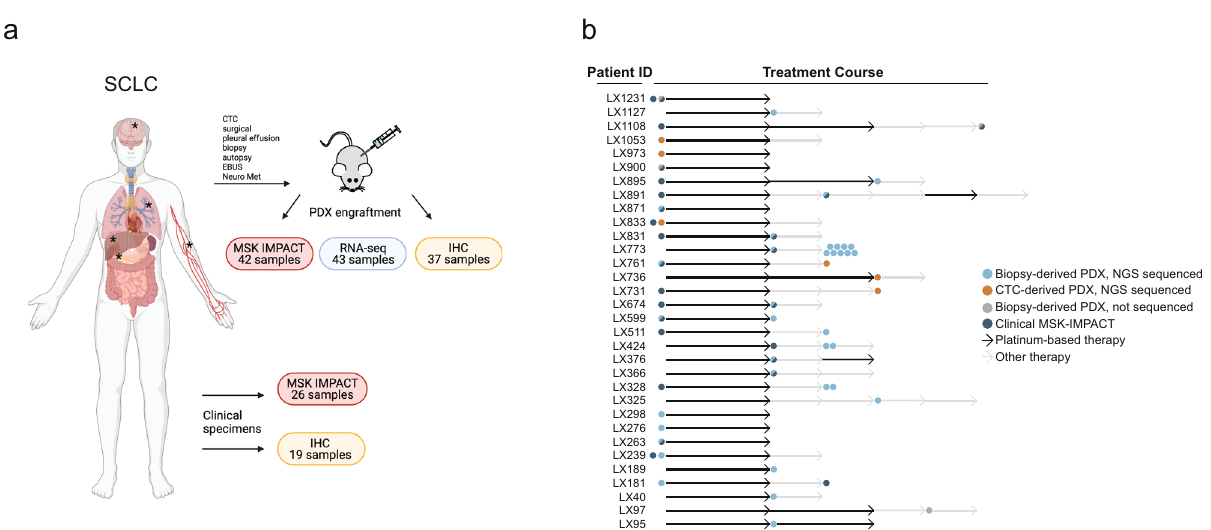
Fig. 1 Generation of the PDX/CDX panel. a Overview of the patient-derived/circulating tumor cell-derived xenograft (PDX/CDX) cohort and clinical specimens. Samples were collected from surgical, pleural effusion, biopsy, autopsy, EBUS, Neuro Met, and CTC isolation and either engrafted into immunode fi cient mice to generate PDX/CDX models or directly sent for targeted sequencing (MSK-IMPACT) and Immunohistochemistry (IHC). Created with BioRender.com. b Swimmers Plot depicting sample collection of the PDX/CDX cohort during treatment course (Platinum-based therapy — black arrow, Other therapy — gray arrow). Models derived from biopsies are annotated with a blue or gray dot (with next-generation sequencing [NGS] or not, respectively). Models derived from circulating tumor cells (CTC, sequenced with NGS) are annotated with an orange dot. Dark blue indicates NGS (MSK- IMPACT) for the clinical sample. Arrows are not to scale in terms of treatment